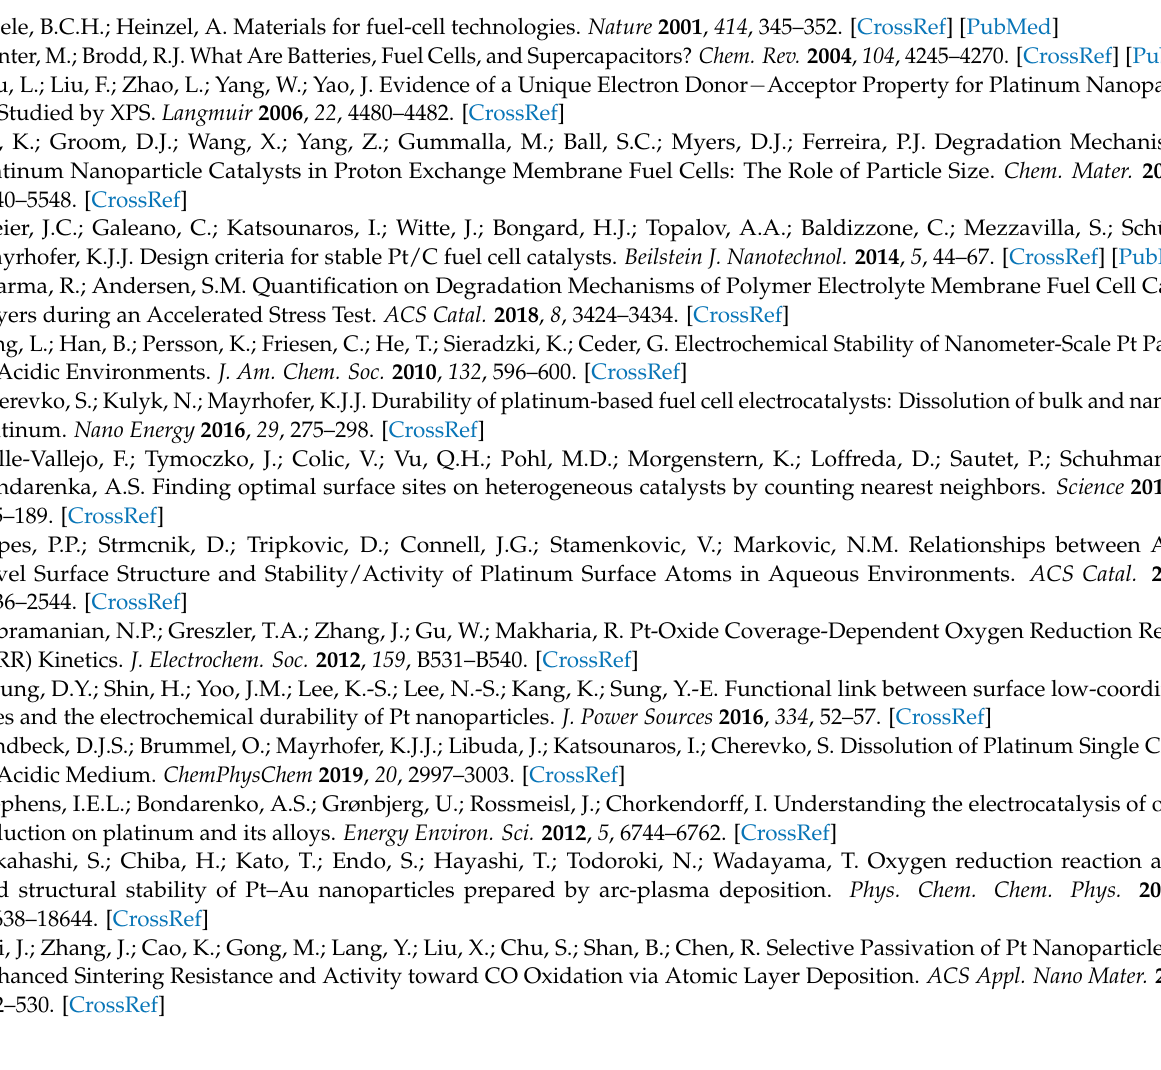
Figure S4: STEM-EDS HAADF and elemental mapping images of 8.4-MPTES–Pt/C after ADT; Figure S5: Electrochemical analysis results of 1-butanethiol adsorbed-Pt/C; Figure S6: XPS analysis of Pt/C treated with excess amount of